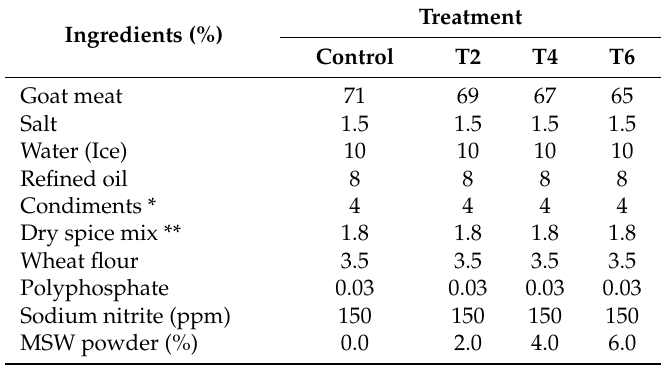
Table1. Formulationofgoatmeatnuggetswithdi ff erentlevelsofmushroomstemwaste(MSW)powder. Treatment Ingredients (%) Control